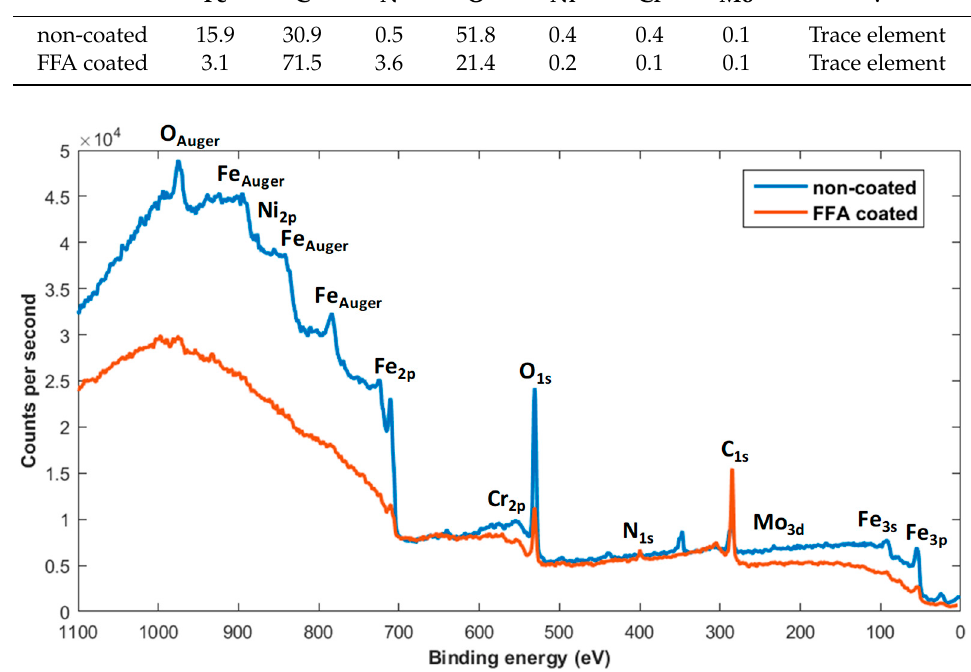
Figure 6. X-ray photoelectron spectroscopy (XPS) overview scan spectra of non-coated and FFA-coated NiCrMoV steam turbine steel.